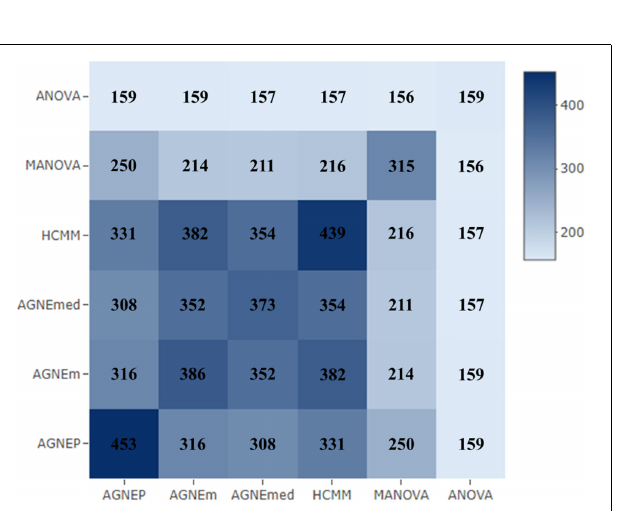
FIGURE 6 | The plot of top 100 significant SNPs of six methods in the analysis of 19 traits. (Left) The hierarchical cluster diagram of 19 traits. (Right) The bubble chart of P -value.